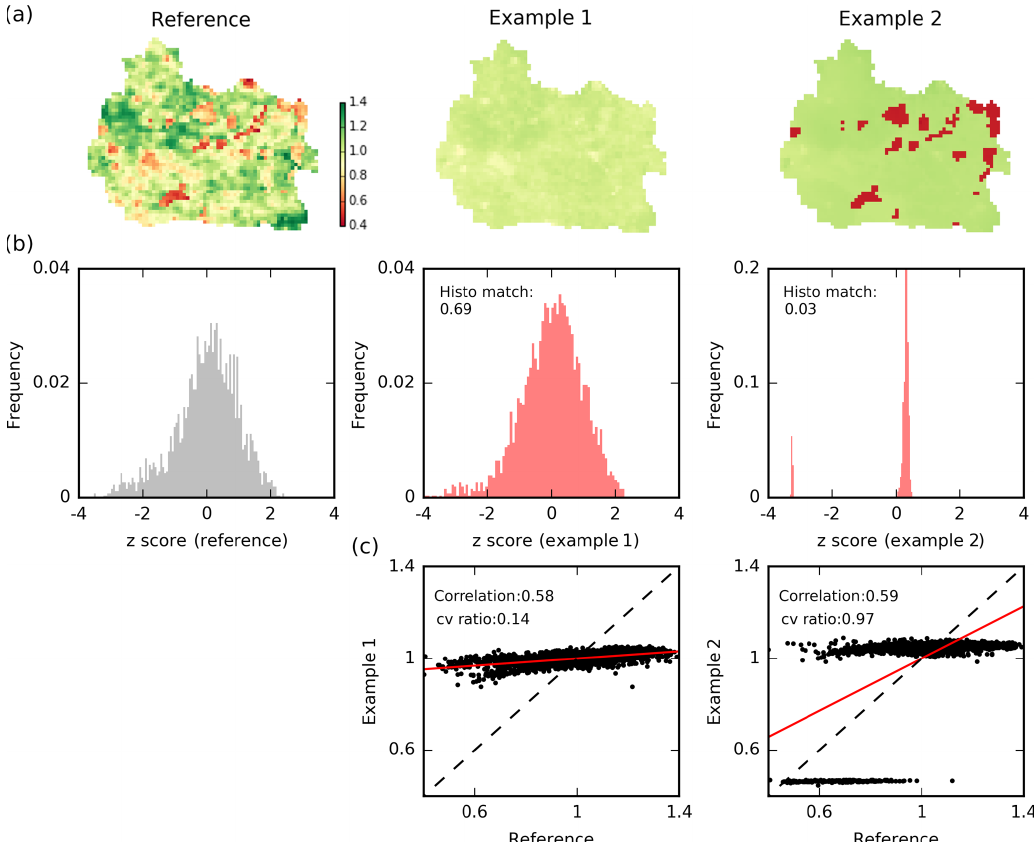
Figure 3. Two examples to illustrate the importance of a multi-component analysis when comparing spatial patterns (a) . The maps are normalized by their mean. The histograms of the z score normalized maps are presented in (b) . The scatter plots of the mean normalized maps are given in (c) . Scores for the three SPAEF components (histo match, cv ratio and correlation) are given in the